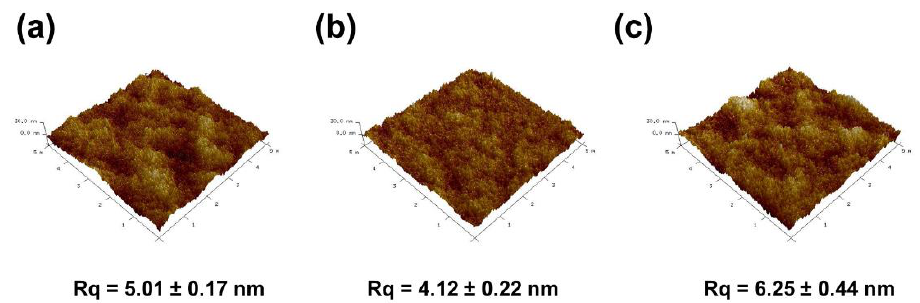
Figure 5. Three-dimensional atomic force microscopy (AFM) images of ( a ) PES; ( b ) PES PDA0.3 ; ( c ) ( c ) PES Ag-PDA0.3 . Lateral scale = 5 µ m; vertical scale = − 30 to 30 PES Ag-PDA0.3 . Lateral scale = 5 μm; vertical scale = −30 to 30 nm.